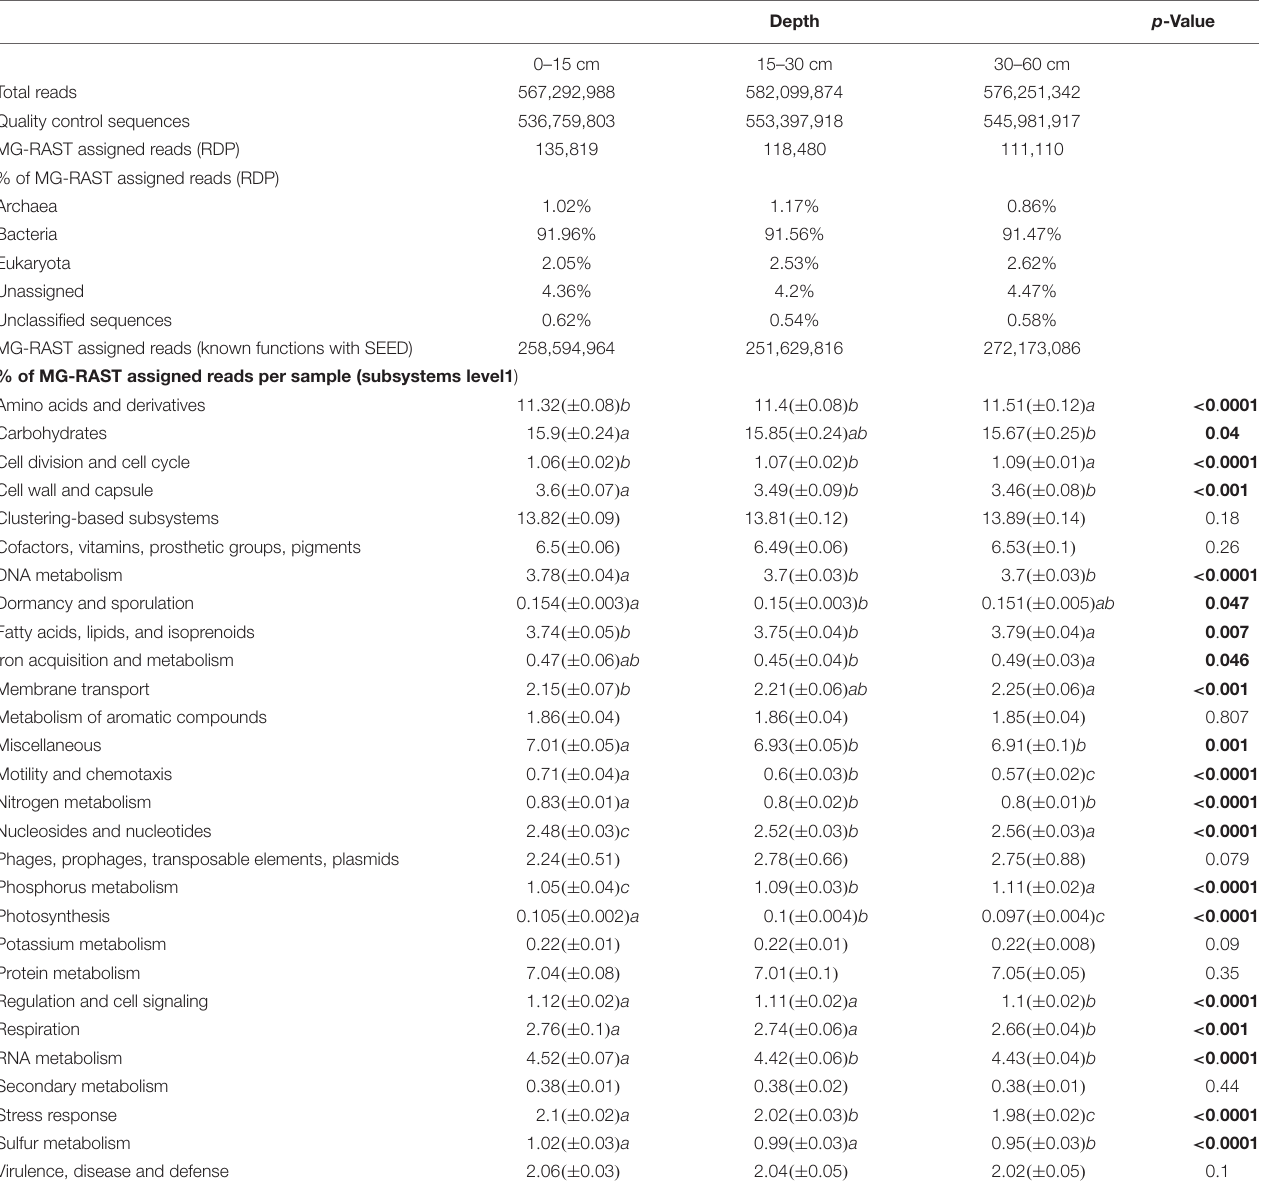
TABLE 1 | Summary of original sequences and sequences processed through MG-RAST pipeline, and relative abundance of functions on subsystem level 1 at different soil depths. Values are means ± std. err. ( n = 15).